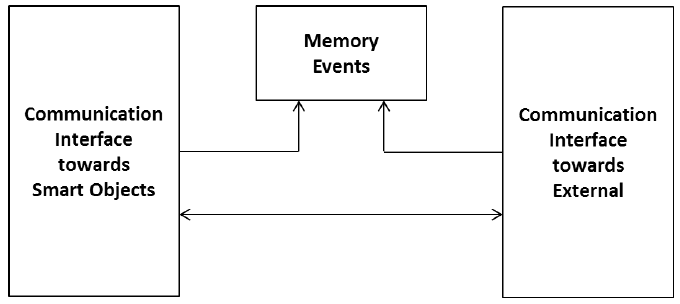
Figure 3. Block diagram of Communication system (ref. Figure 2, Zabbix Proxy